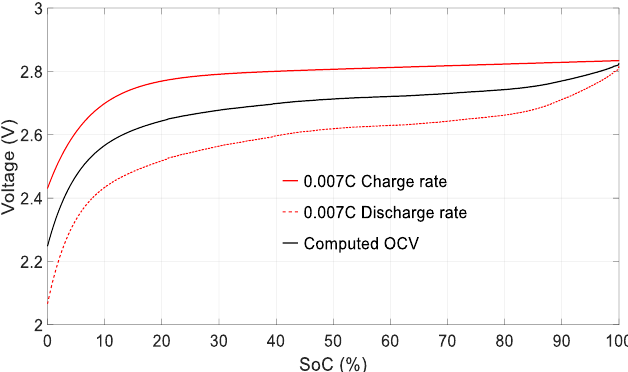
Figure 8. Open circuit voltage V OCV versus SoC obtained by averaging the terminal battery voltage during an entire charge and discharge cycle at 0.007 C.